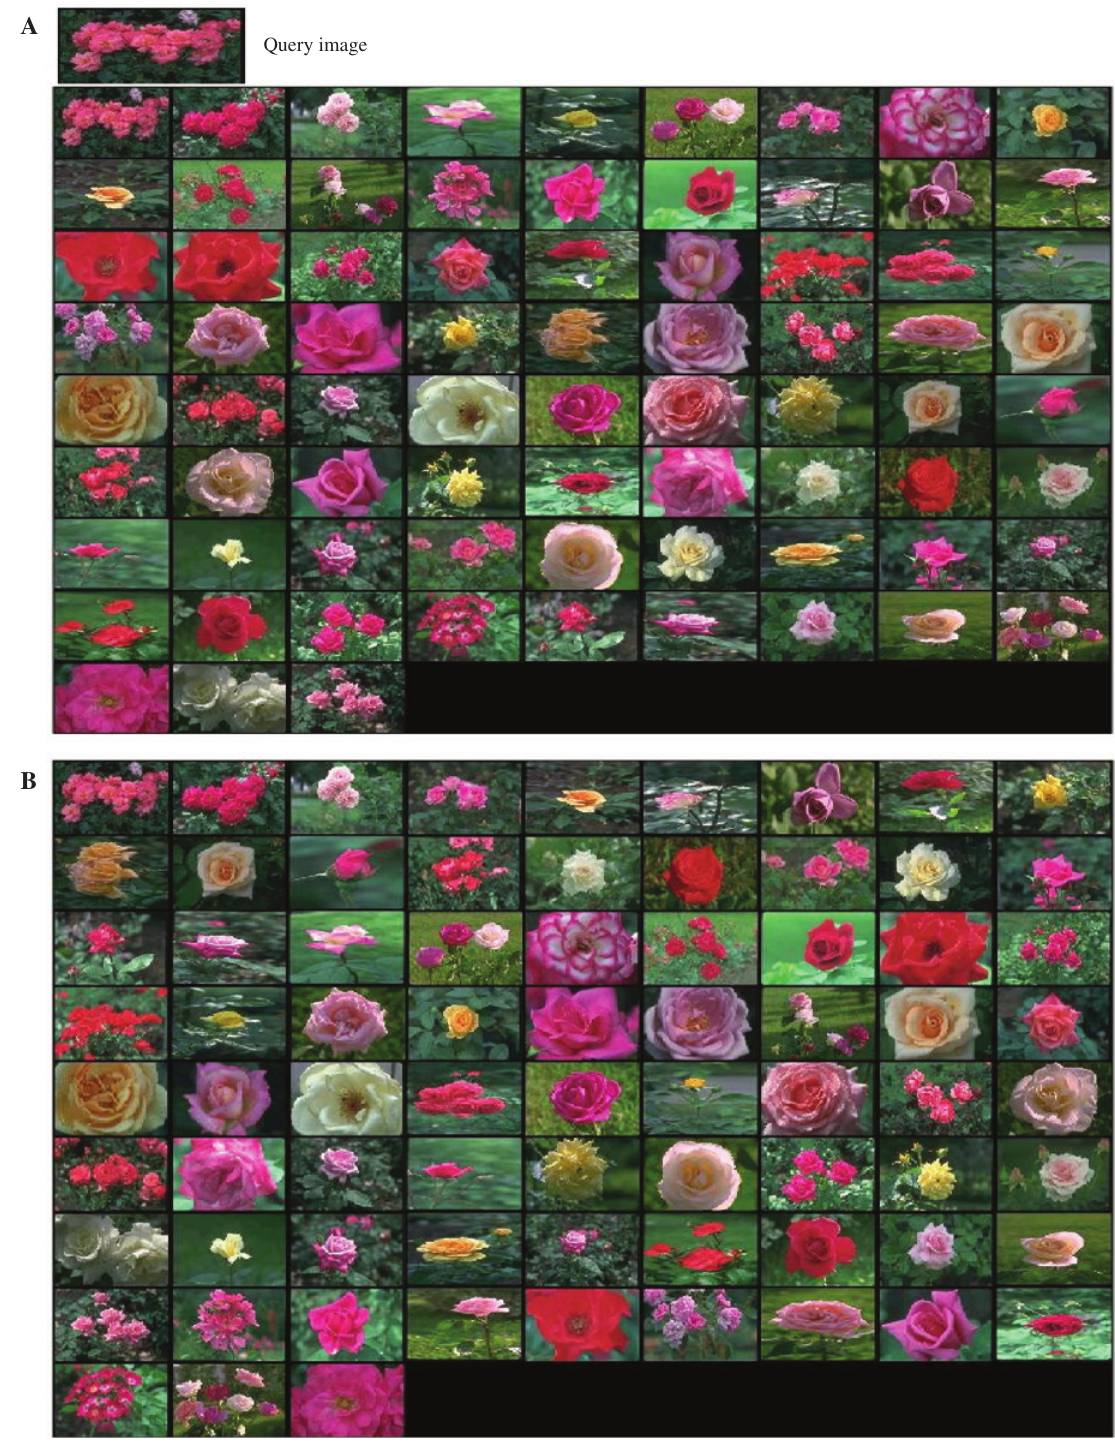
Figure 7: Retrieval Example Using Query Image (Rose). (A) First-level retrieval output images. (B) Re-ranked image